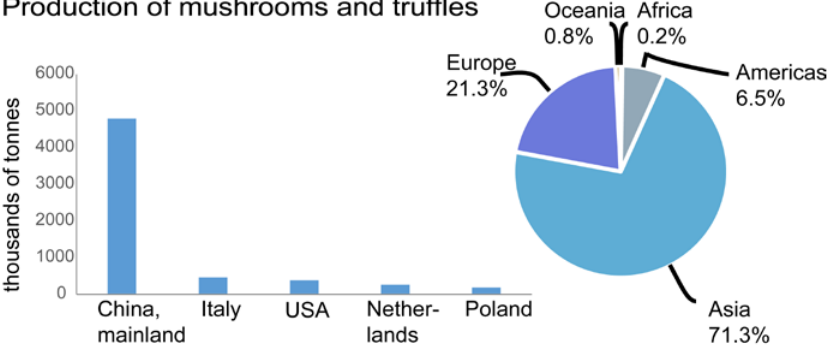
Figure 1. Worldwide production of mushrooms and truffles, average from 2004 to 2014 [5].